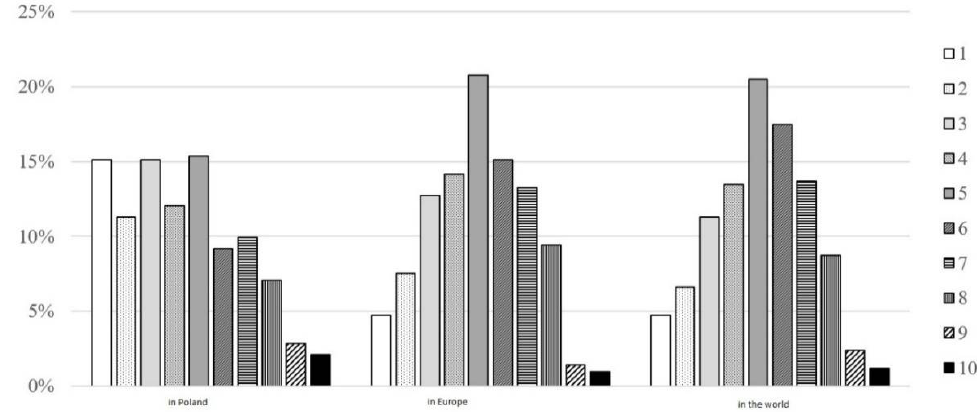
Figure 2. Assessment of the image of the Catholic Church in Poland, Europe and worldwide. Source: authors’ own elaboration.